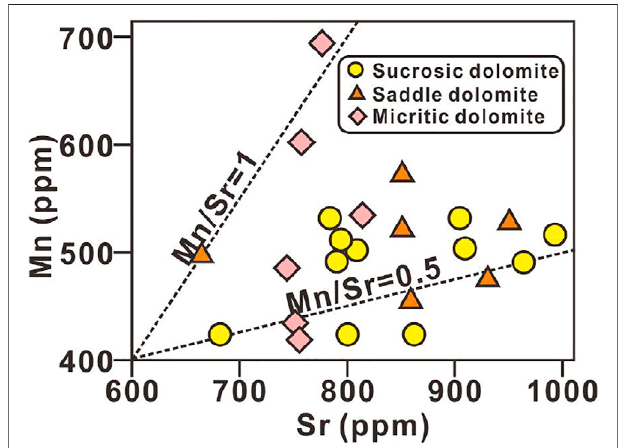
FIGURE 3 | Crossplots showing Mn/Sr ratios exclusively less than 2.